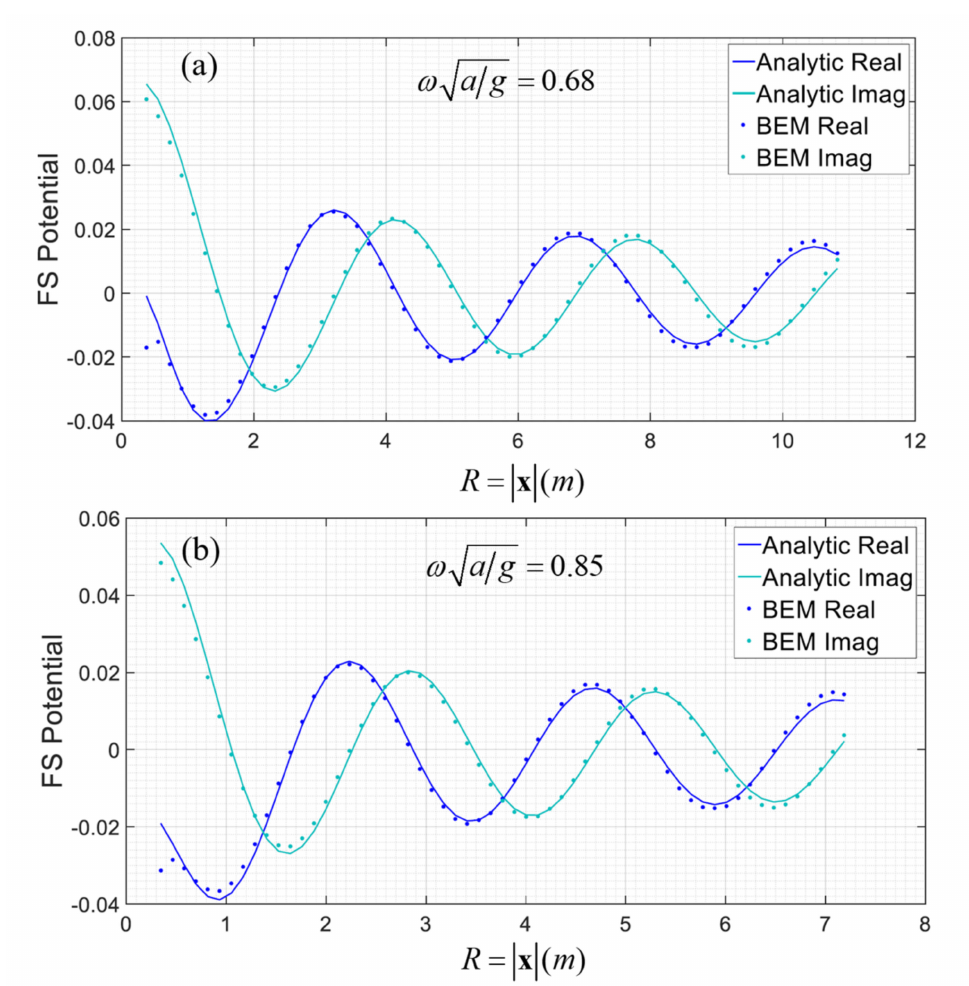
Figure 7. Comparison of BEM results (shown by using dots) with the analytical solution (solid lines) concerning the free surface potential of heaving cylinder for ( a , b ), (cid:101) ω = ω case of the cylindrical floating body with parameters R w / h = 1/3.5, d / R w = 3/2, c / h =